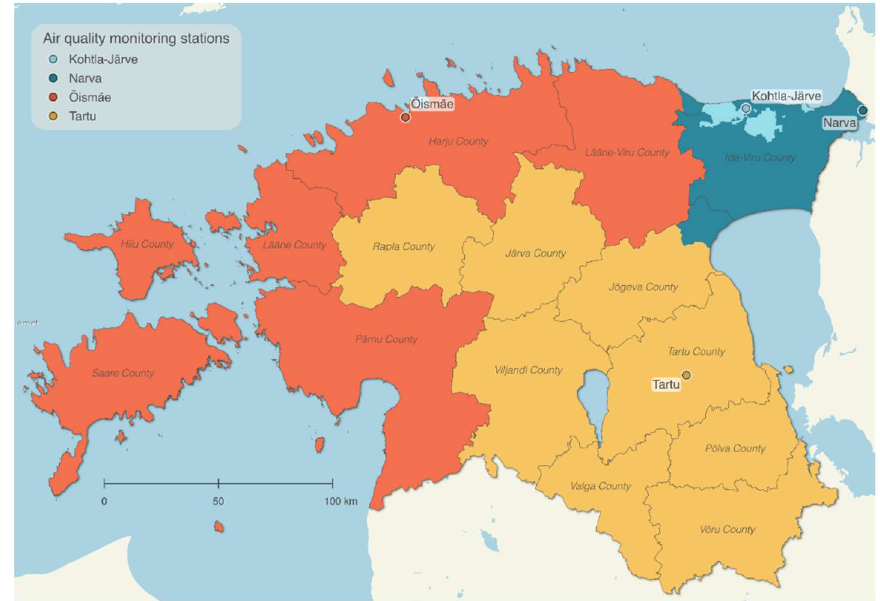
Figure 1: Tallinn Õismäe (Baltic Sea bordering Counties), Tartu (inland Counties), and Narva and Kohtla–Järve (municipalities in Ida-Viru County).